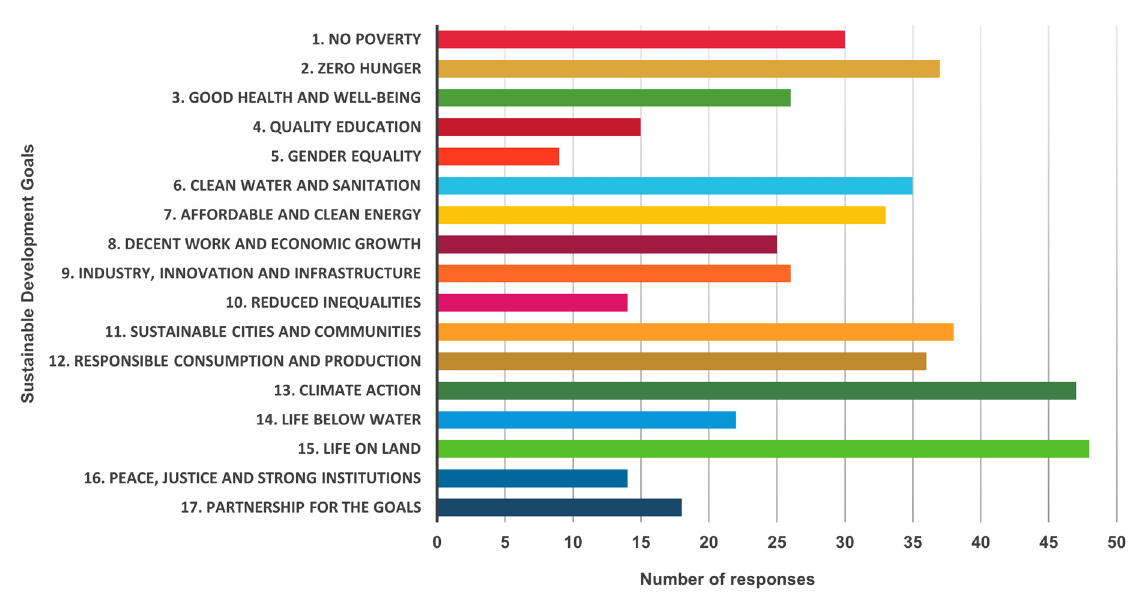
Figure 1. Land cover in the Sustainable Development Goals. Reprinted/adapted with permission from Ref. [25]. 2022, FAO and ISO/TC211 AG13.